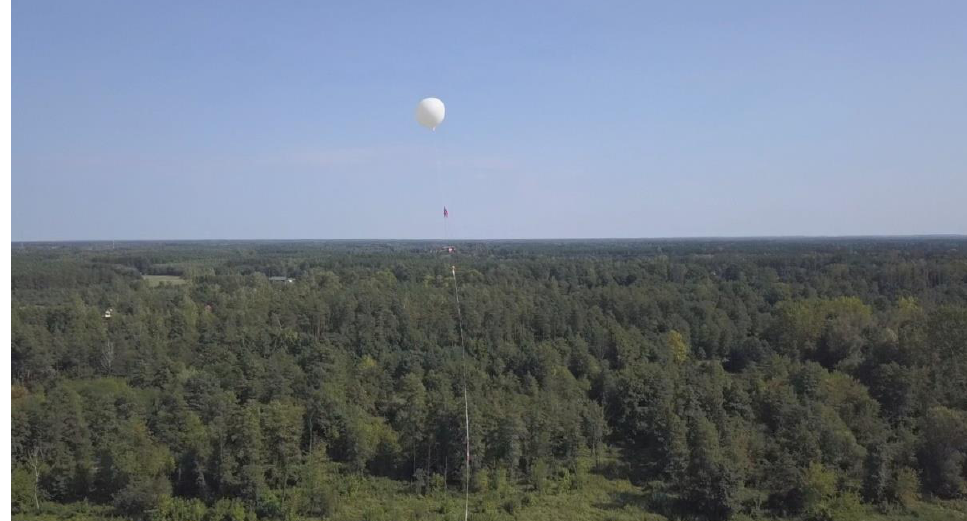
Figure 5. An example of the launch of a light stratospheric balloon mission (12 September 2018) with the deployment of a 40 m-long vertical antenna; seen from the top: the balloon, the parachute, the main gondola, the antenna fixing insulator and the antenna (aluminum tape-form) during deployment.